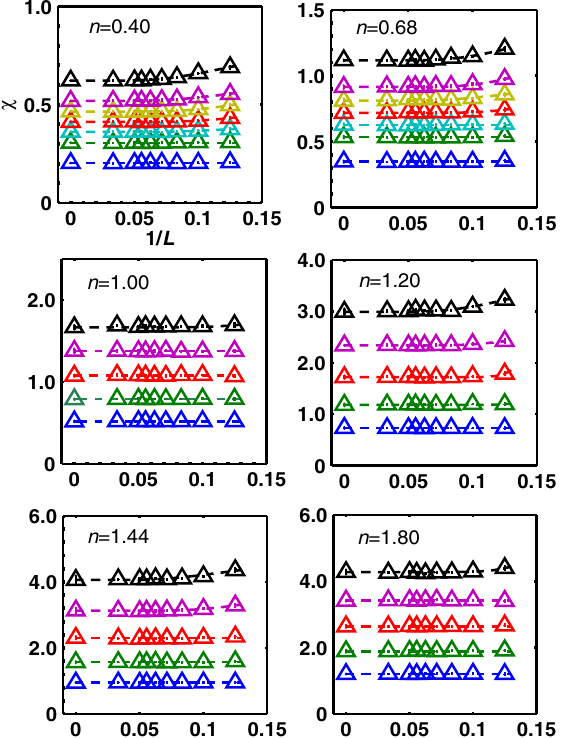
FIG. 12. The finite -size scaling of χ ð T; L Þ versus 1 =L for V ¼ 8 . Scaling ansatz χ ð T; L Þ ¼ aLe − L=b þ χ ð T Þ is used. The legend is the same as in Fig. 11.